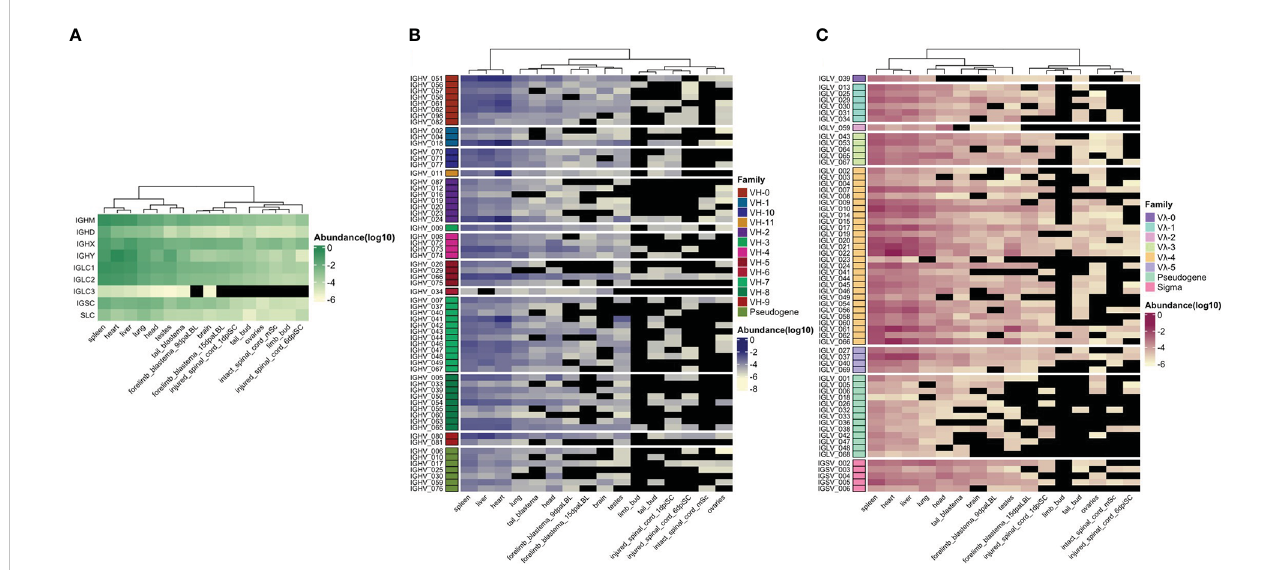
FIGURE 4 Relative immunoglobulin gene transcription (Log10 relative abundance). Publicly available RNA-seq data (SRA: SRP101842) (17) was used to estimate relative gene transcription in 13 adult tissues (spleen, liver, heart, lung, testes, ovary, brain, head, 9 and 15 day post - amputation forelimb blastemas, tail blastema, intact, 1 and 6 days post-injured spinal cord), limb and tail buds. A hierarchical clustering by column (tissue) was performed. (A) Immunoglobulin C region relative transcription. (B) IGHV relative transcription. Each IGHV gene is grouped by IGHV family (rows). (C) IGLV and IGSV relative transcription. Each IGLV segment is grouped according